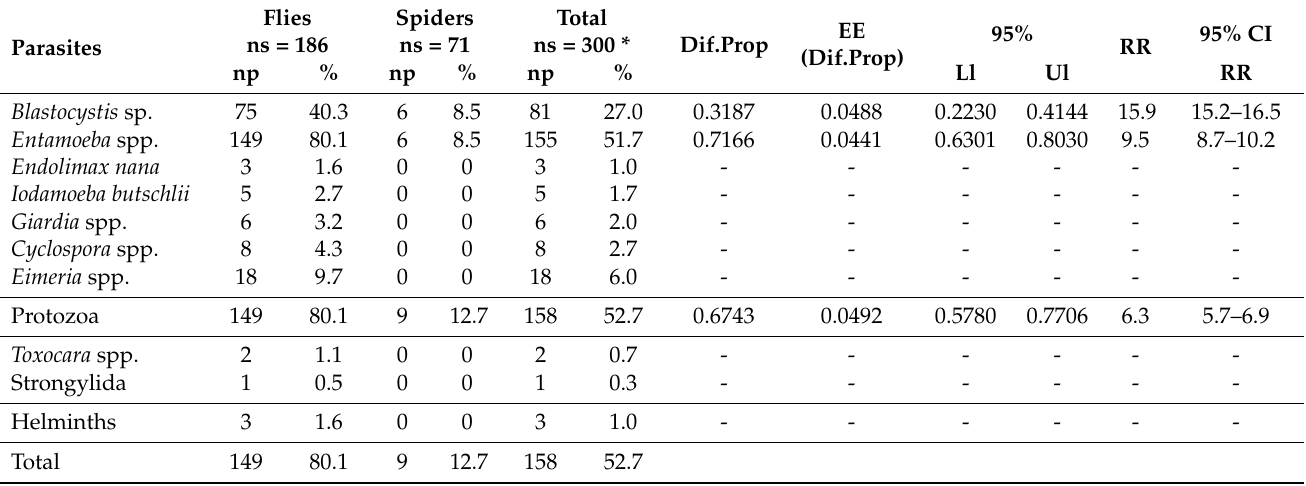
Table 1. Distribution of the frequency of parasite contamination according to mechanical